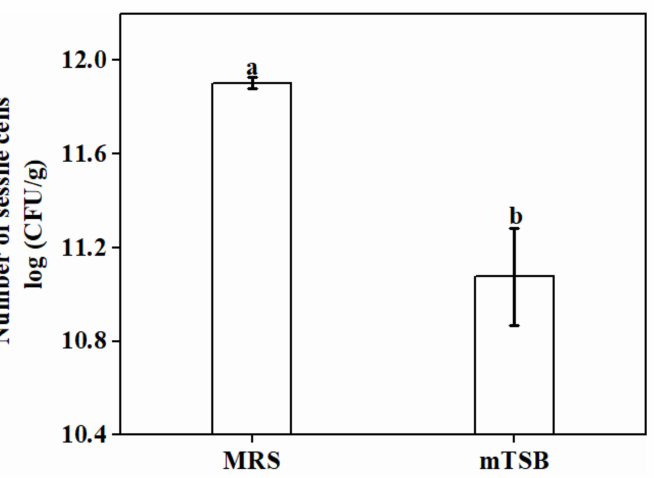
Figure 2. The effect of medium type on the number of sessile cells in biofilms. Significant differences ( p < 0.05) are indicated by different letters (a and